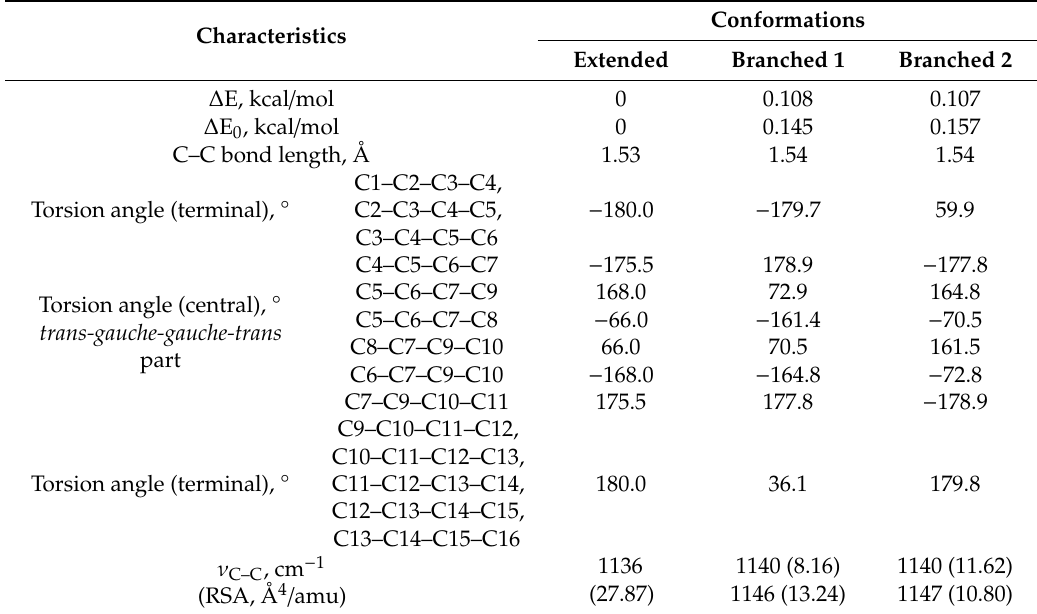
Table 3. DFT calculated characteristics of the hydrogenated 1-octene dimer conformations.